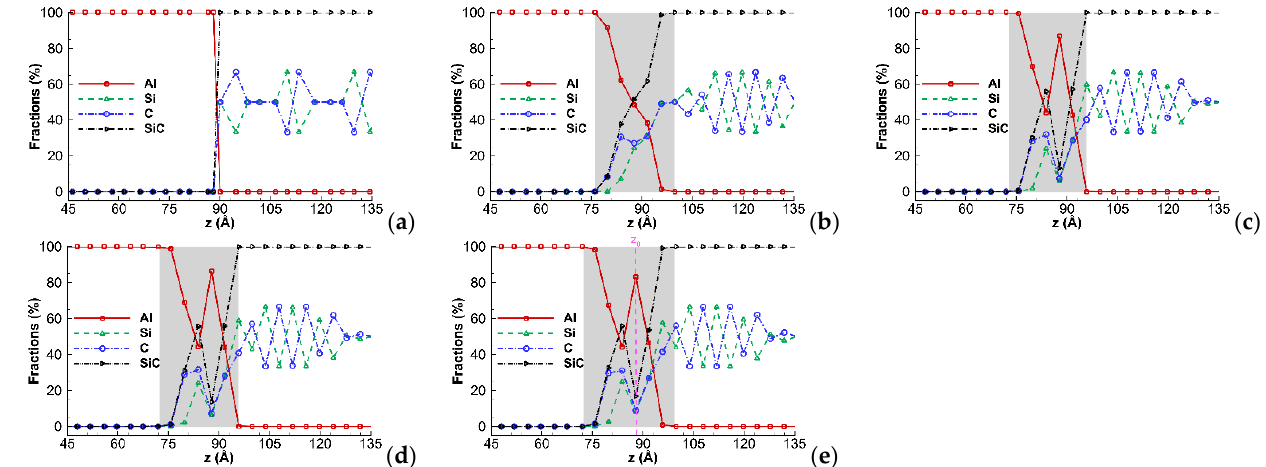
Figure 5. Concentration profiles of Al, Si, and C atoms along the z -direction during interdiffusion of the C-terminated 3C–SiC/Al interface. The grey zone in the figures indicates the diffusion zone and its thickness. ( a ) Atomic structure at 300 K before relaxation and the configuration after main- taining the system at 2000 K for ( b ) 0 ns, ( c ) 2 ns, ( d ) 4 ns, and ( e ) 6 ns. the system at 2000 K for ( b ) 0 ns, ( c ) 2 ns, ( d ) 4 ns, and ( e ) 6